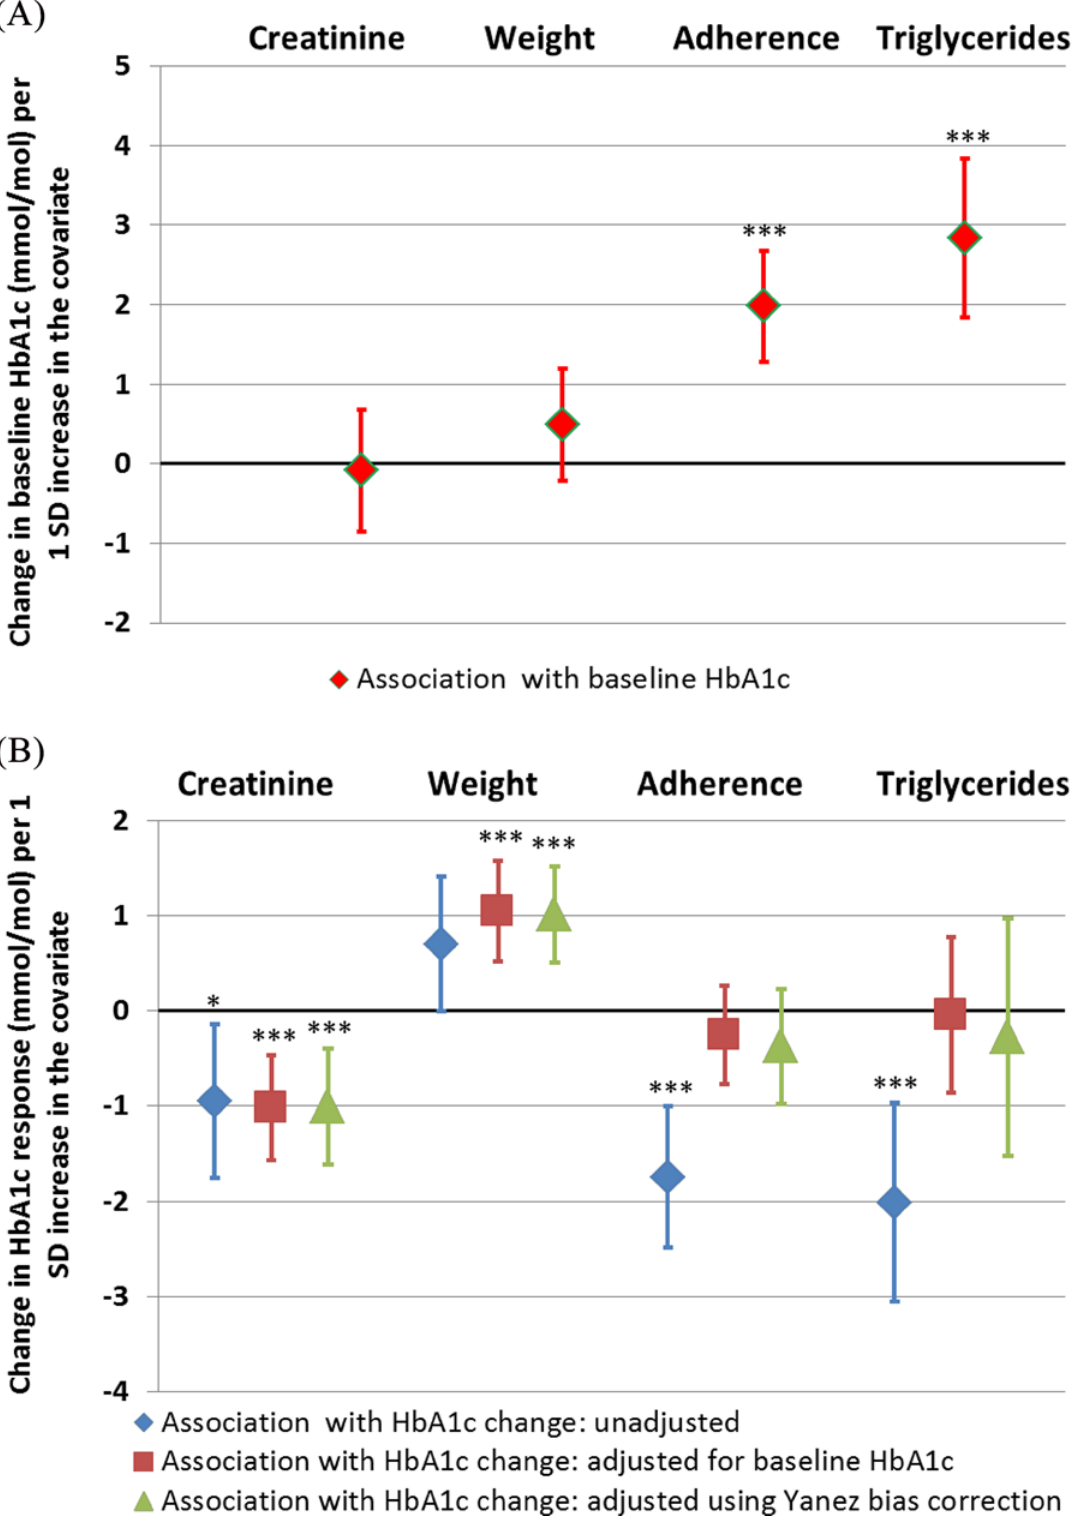
Fig 5. The association between baseline covariates and A: baseline HbA1c, and B: glycaemic response to Sulfonylurea therapy, with and without adjustment for baseline HbA1c and Yanez bias correction. Effect sizes presented indicate A) baseline HbA1c or B) HbA1c response (6 months –